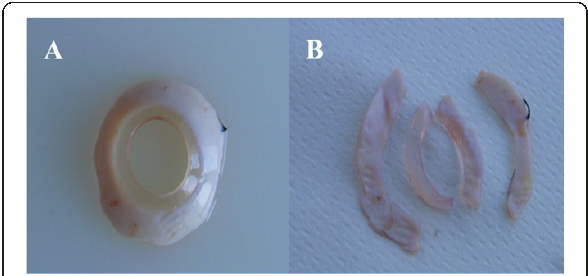
Figure 1 A-B. The surgical specimen. Peripheral corneal tissue obtained after penetrating